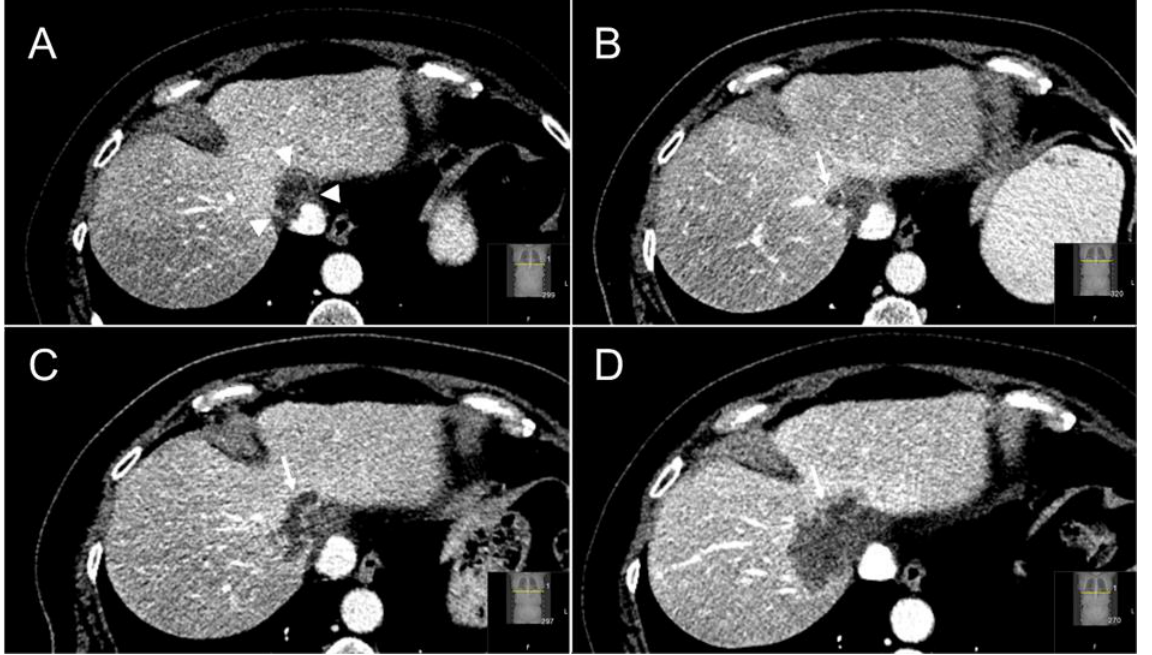
Figure 5. Follow-up cross-sectional ceCT images of a segment IVa-VIII CRLM treated with SABR. At three months ceCT showed a typical halo sign of hypoattenuation directly surrounding the irradiated, largely necrotic tumor (white arrowheads) and characteristic hyperattenuation of the perilesional liver parenchyma, which correlates with radiation induced hepatic fibrosis ( A ). At six months a solid ring-enhancing nodular lesion (white arrow) can be appreciated at the right-lateral margin of the irradiated tumor ( B ). This appearance is highly specific for the presence of local tumor progression post-SABR. Follow-up ceCT at six and 12 months ( C , D ) further confirmed the local tumor progression.